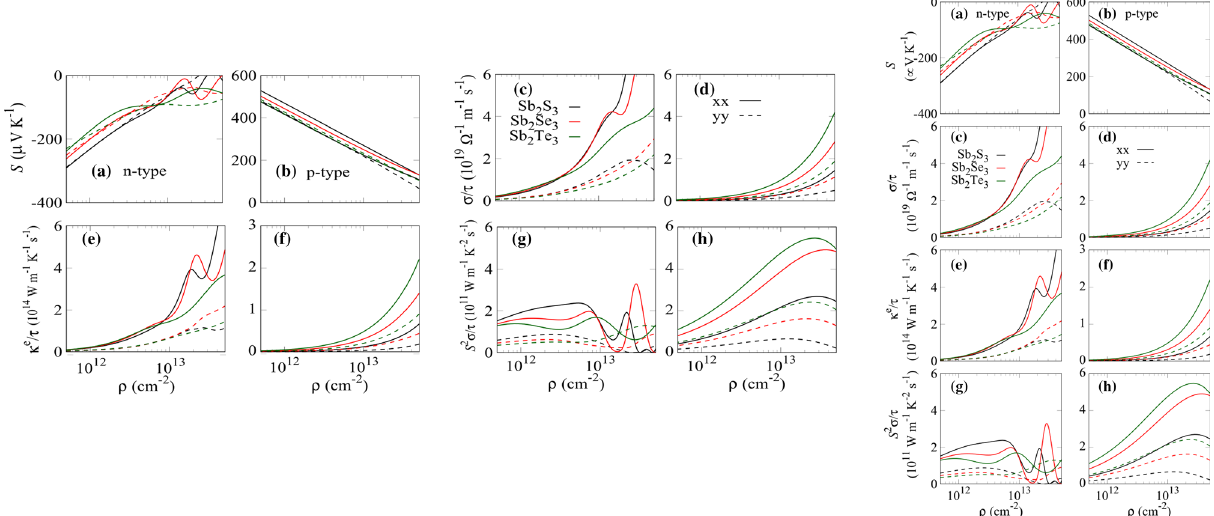
Figure 5. The electrical transport properties as function carrier concentration at 300 K of the Sb 2 X 3 monolayers ( a , b ) Seebeck coefficient, ( c , d ) electrical conductivity, ( e , f ) electronic thermal conductivity, and ( g , h ) power factor. The solid and dashed lines represent the x-and y-direction,